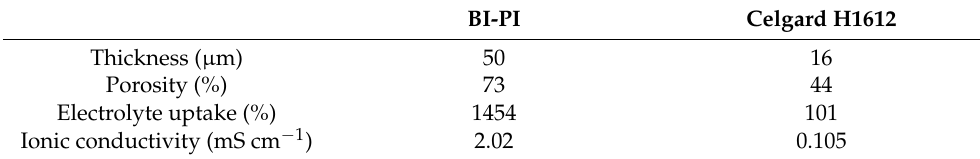
Table 1. Comparison of BI-PI electrospun film and commercial Celgard H1612 separator.